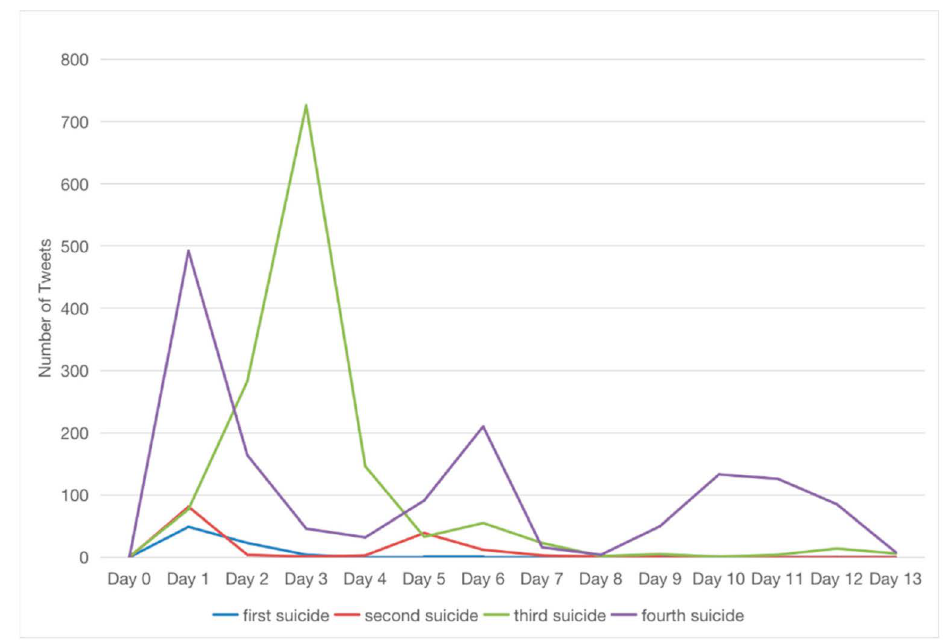
Figure 4. The number of tweets mentioning Vessel and suicide within the first 14 days after each suicide case.